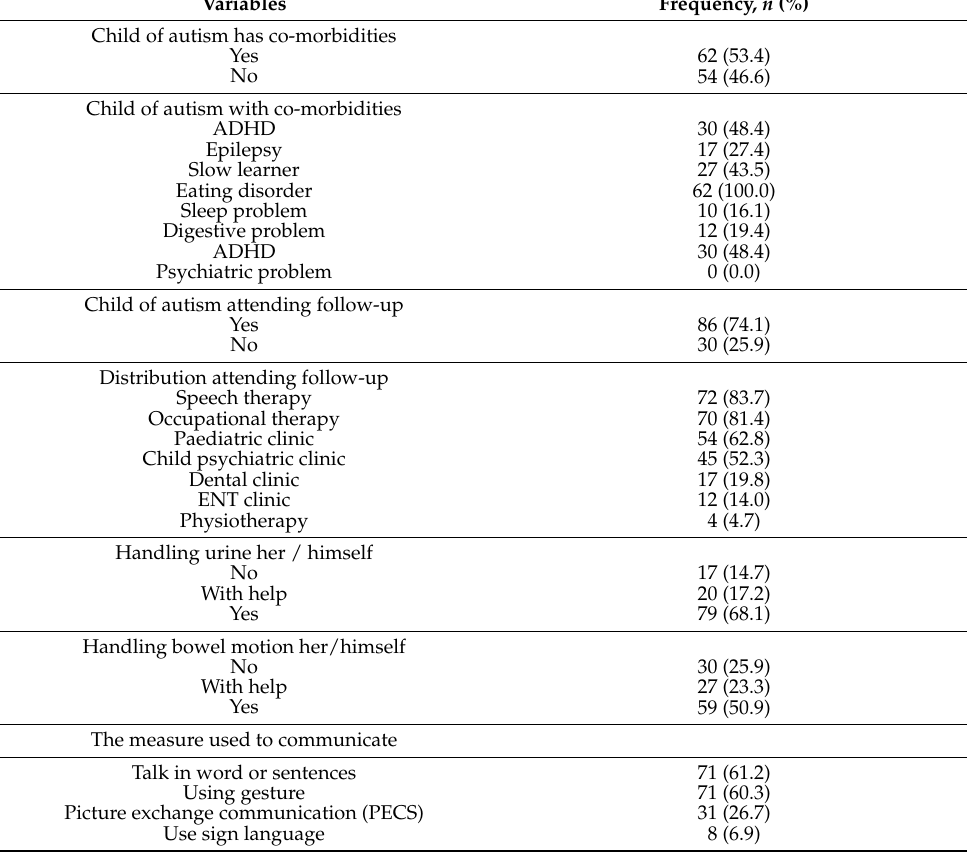
Table 2. Characteristics of the children with ASD ( n =